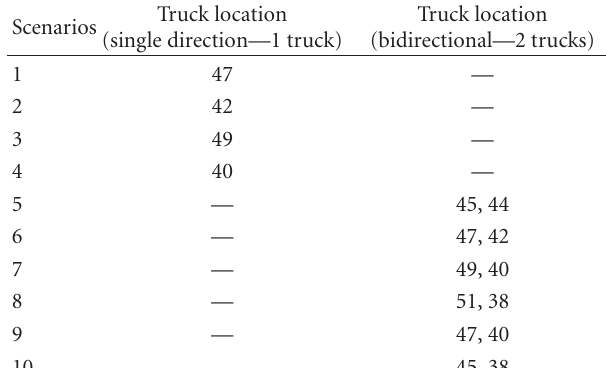
Table 1: Testing